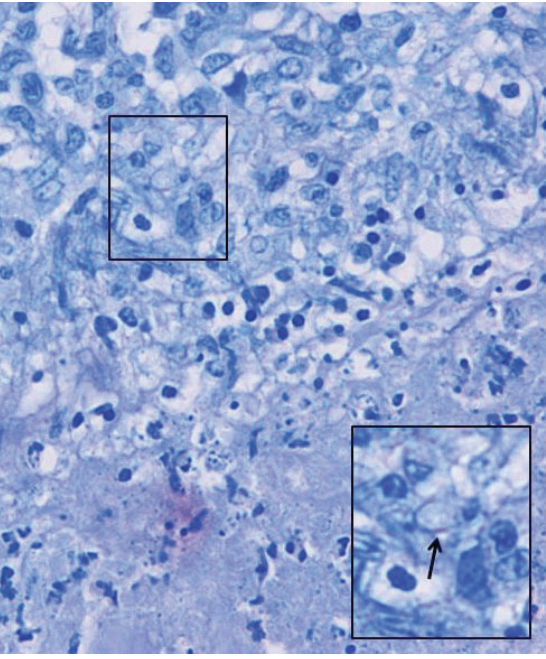
Figure 2. Mycobacterium tuberculosis bacterium (arrow). Acid-fast Ziehl-Neelsen stain: magnification X